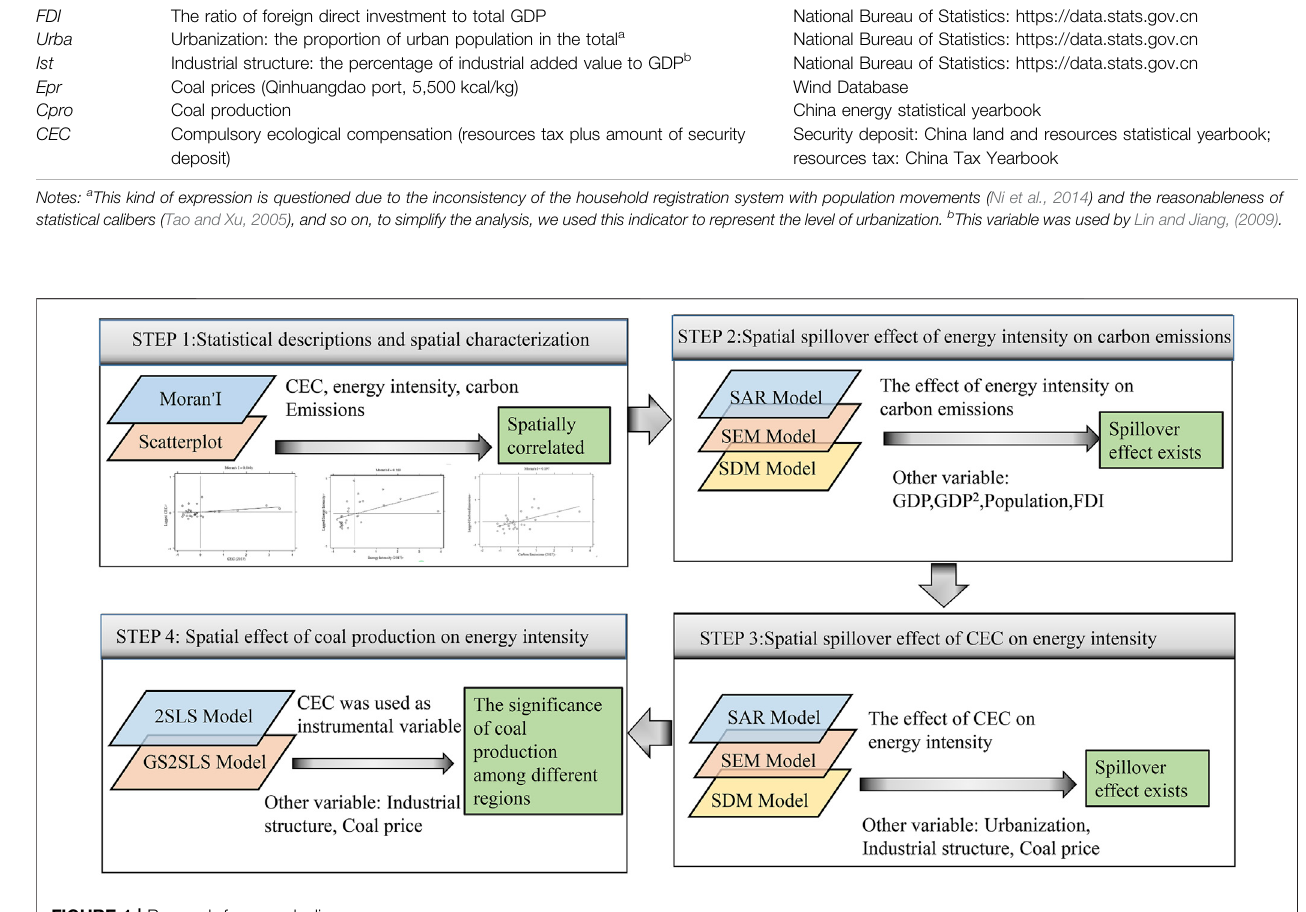
FIGURE 1 | Research framework